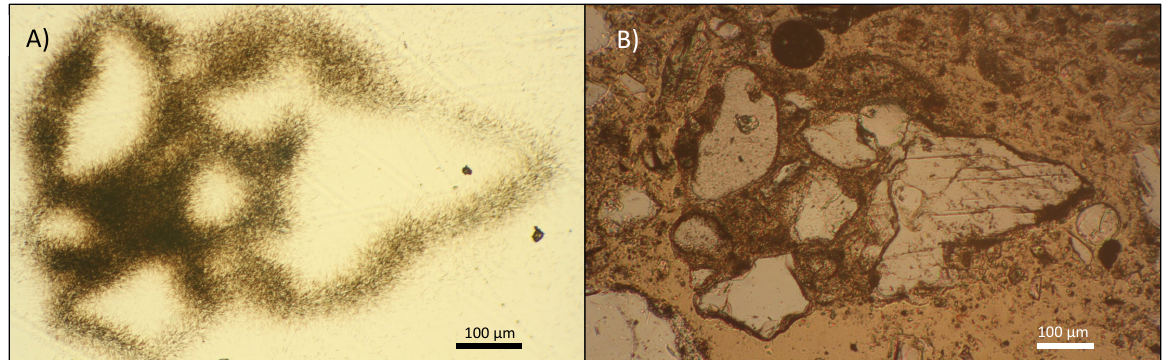
Figure 5. Fission-track and microscope images of sample GJAST-20-10 (Figure 2) with high fission- track grain coating. ( A ) Fission track image at 2.5 × magnification. ( B ) Thin section in plain light at 2.5 × magnification.